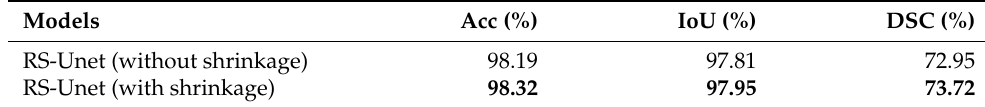
Table 1. Comparison of the model with and without the shrinkage structure.